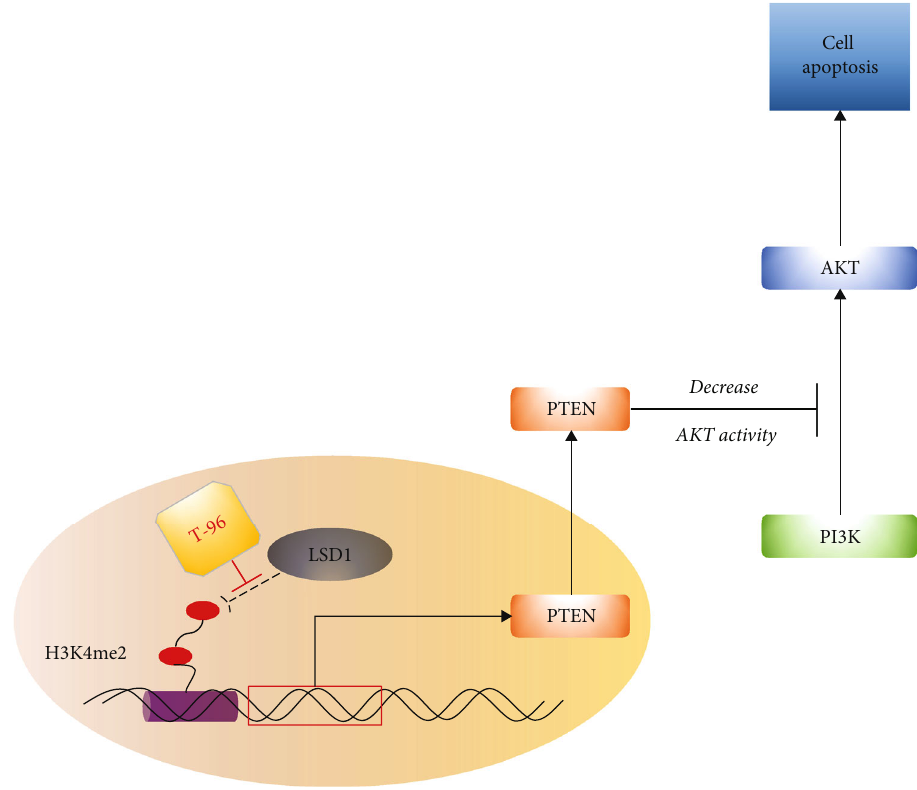
Figure 7: Antitumor e ff ect of T-96 on breast cancer via LSD1-mediate epigenetic